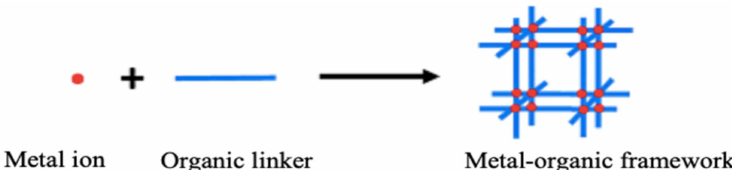
Figure 1. The schematic diagram for the formation of the metal-organic framework (MOF) from metal ion and organic linker as precursors. Reproduced with permission from Reference